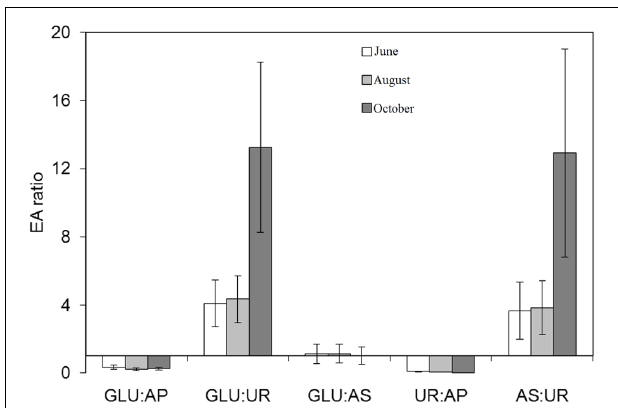
FIGURE 1 | Enzymatic activities (EA) ratios analyzed in sediment samples taken along the ice-free season on June 9, August 1, and October 13, 2015 in lake La Caldera (Sierra Nevada, Spain). GLU, β -glucosidase; UR, urease; AP, acid phosphatase, AS, arylsulphatase. X -axis is the threshold value = 1. Error bars are calculated by propagation errors.